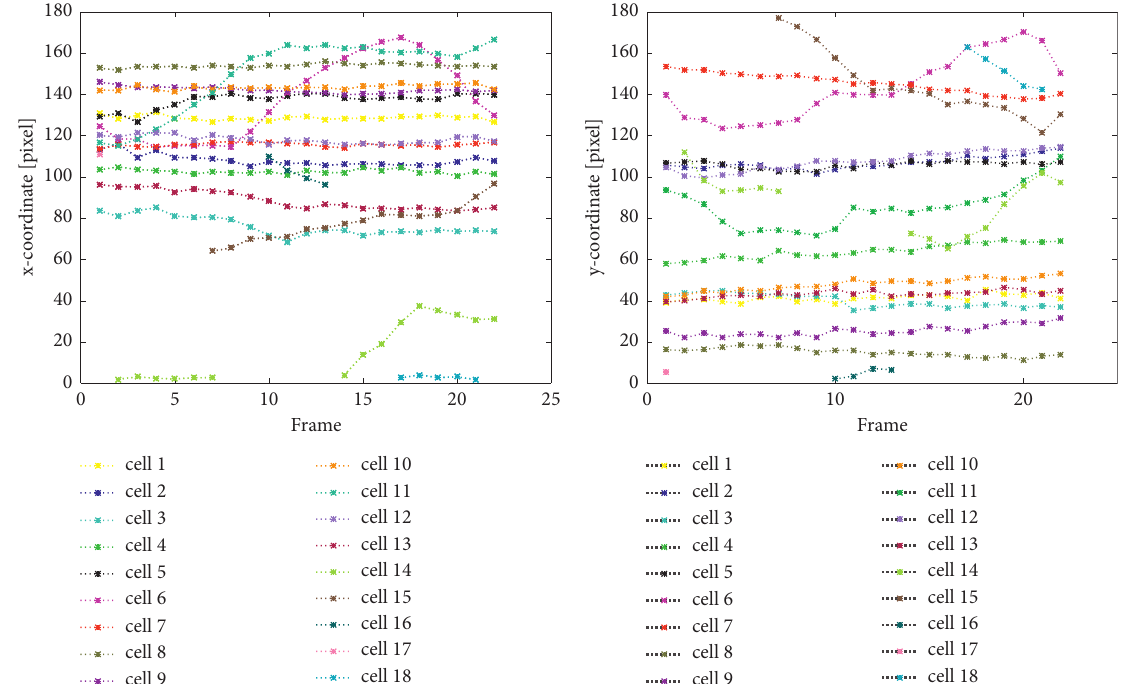
Figure 6: Position estimation of each cell in x and y